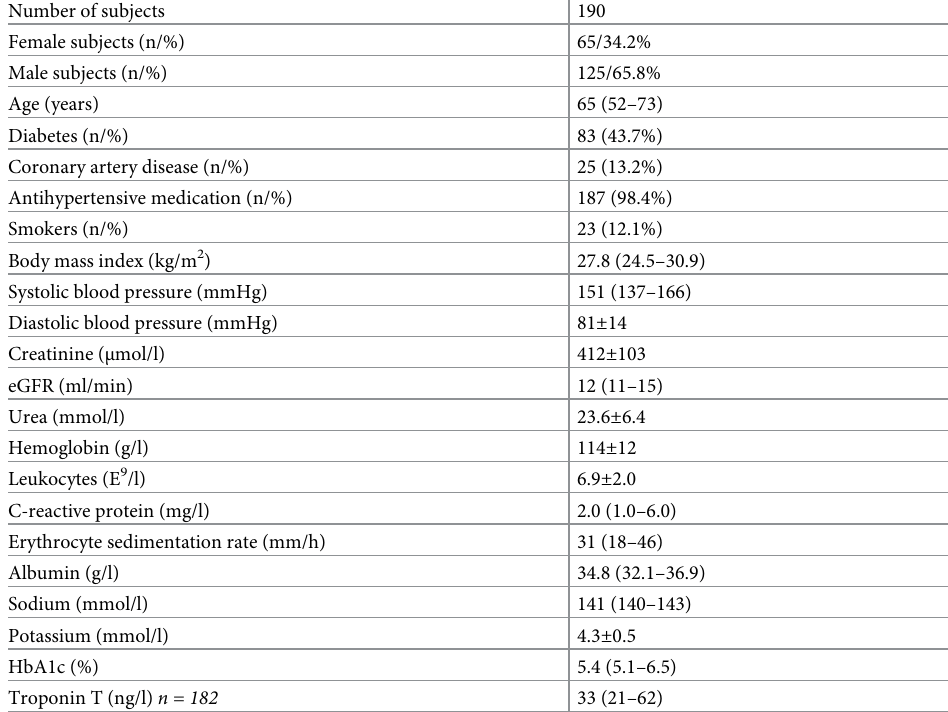
Table 1. Demographic and laboratory characteristics. Values are presented as mean ± SD for normally distributed variables and median (IQR) for skewed